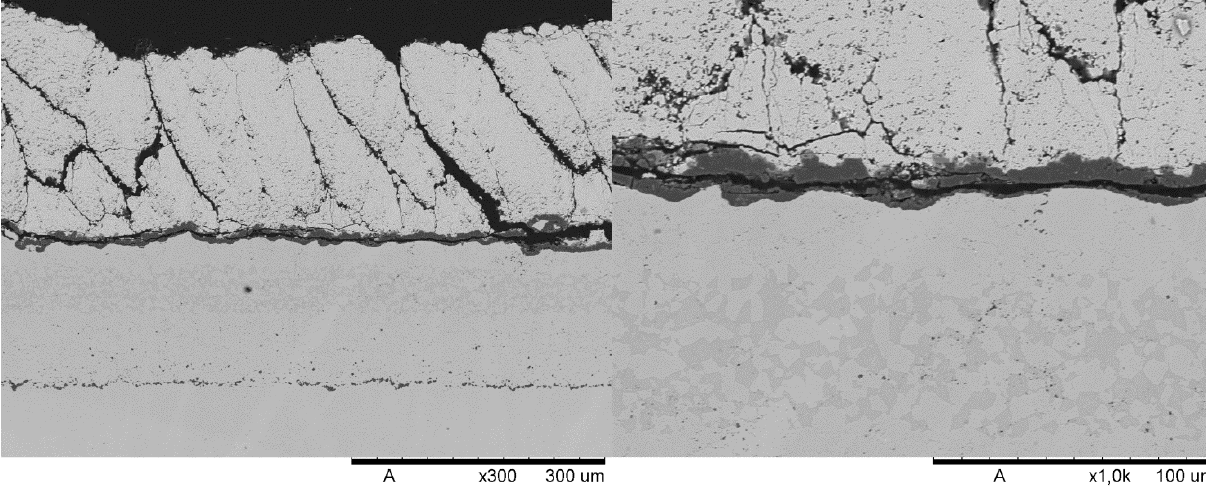
Figure 11. Suspension T3, approximately 350 TCF